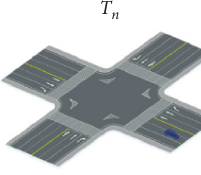
Figure 2: Continuous time series picture.